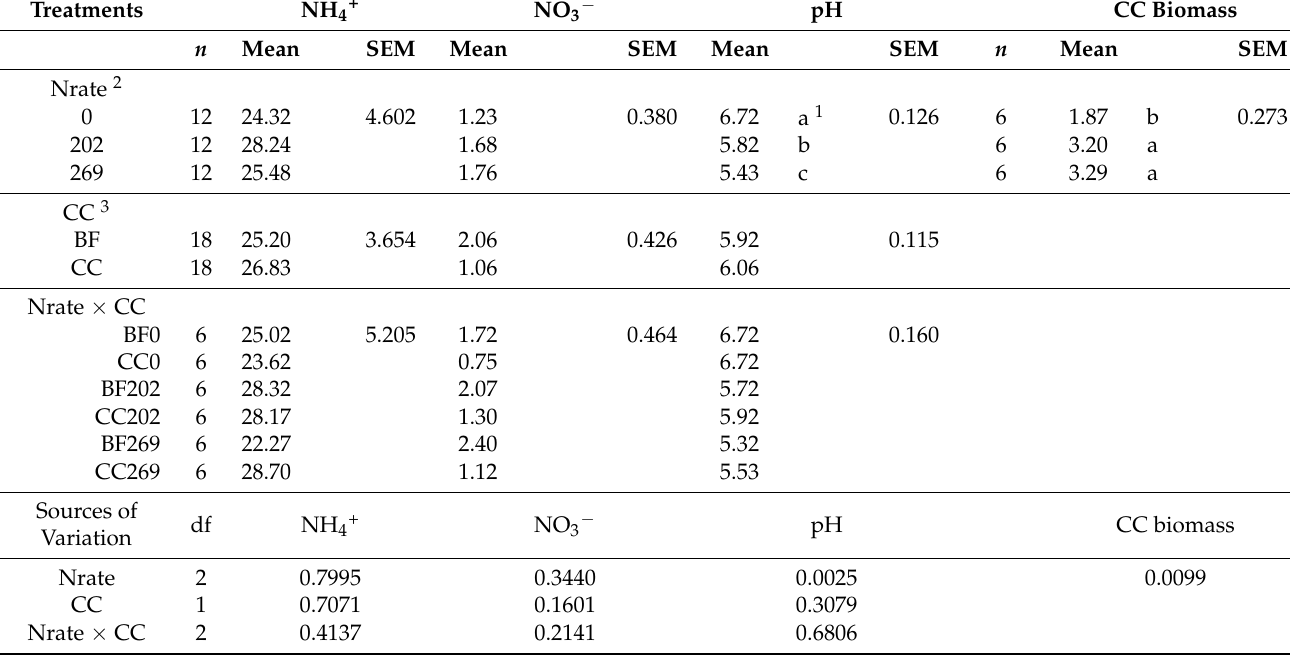
Table 1. The estimated treatment means, standard errors of the treatment mean (SEM), and the sample size ( n ) of the selected soil chemical properties, including soil ammonium level (NH 4+ ; mg kg − 1 ), nitrate level (NO 3 − ; mg kg − 1 ), and soil pH, and cover crop biomass dry weight (CC